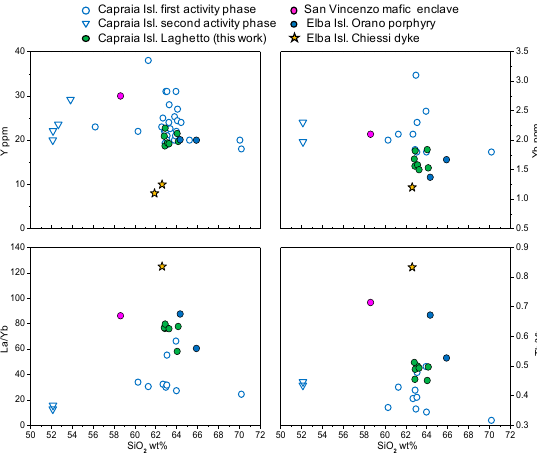
Figure 6. Trace element variation diagrams for Capraia rocks.